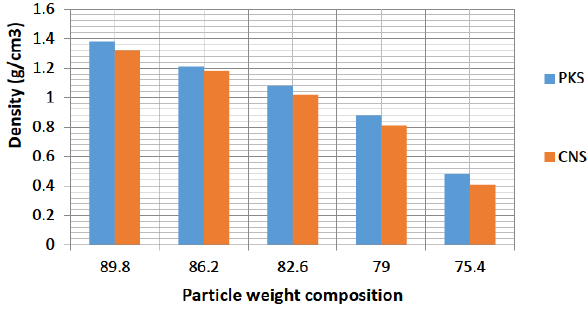
Figure 20: Density of PKS & CNS/% particle weight variation for 420 µ